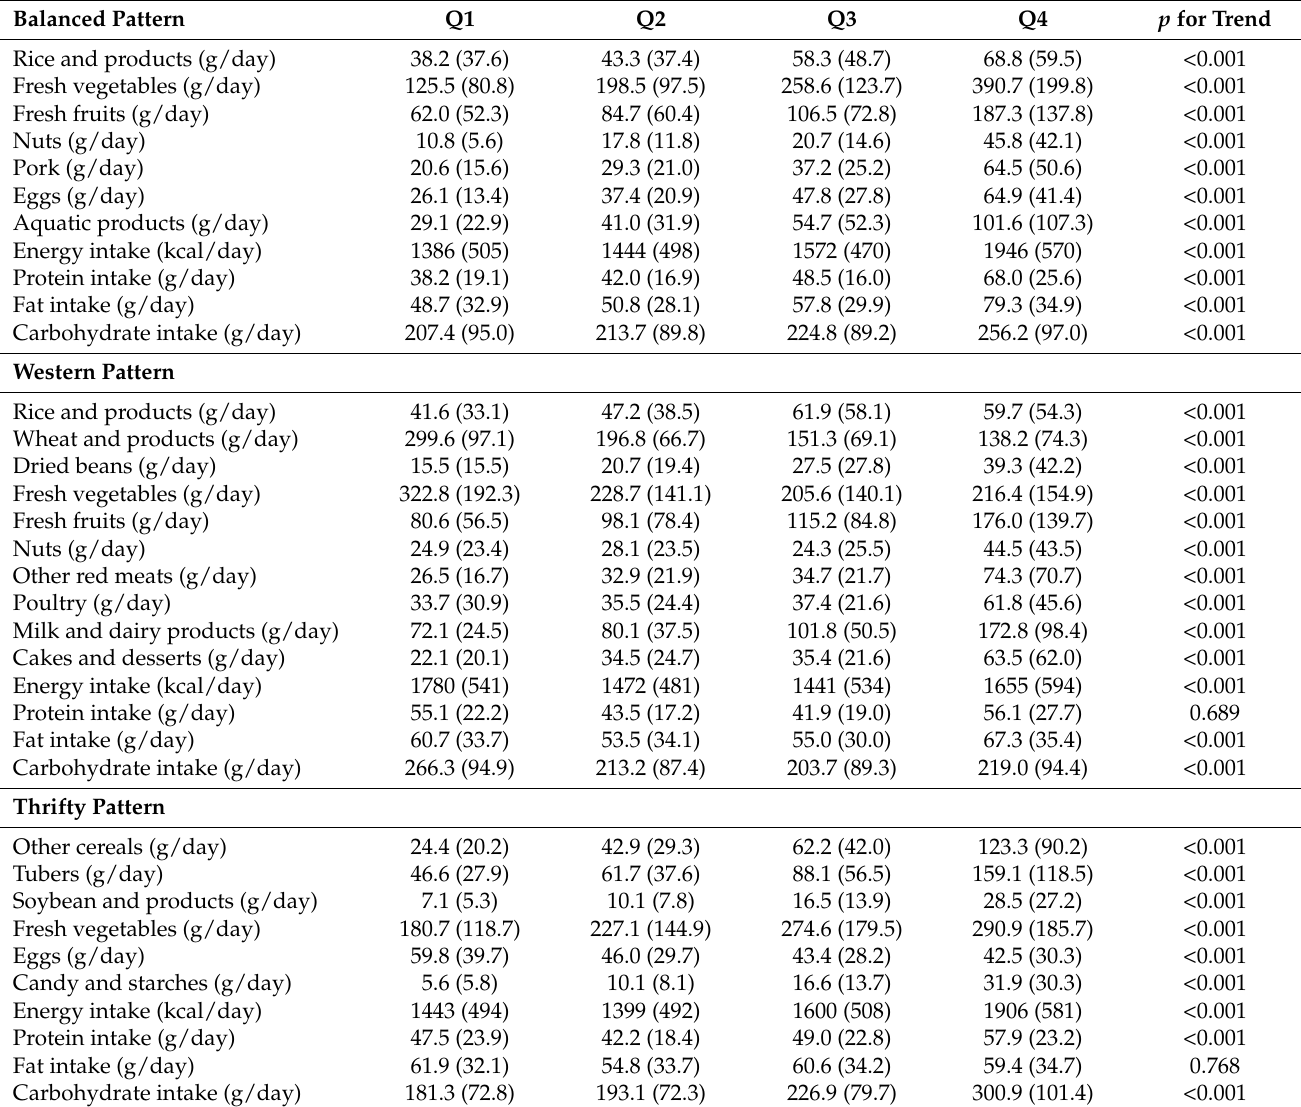
Table 4. Food and macronutrient intake in quartiles of dietary patterns among the older participants (mean,